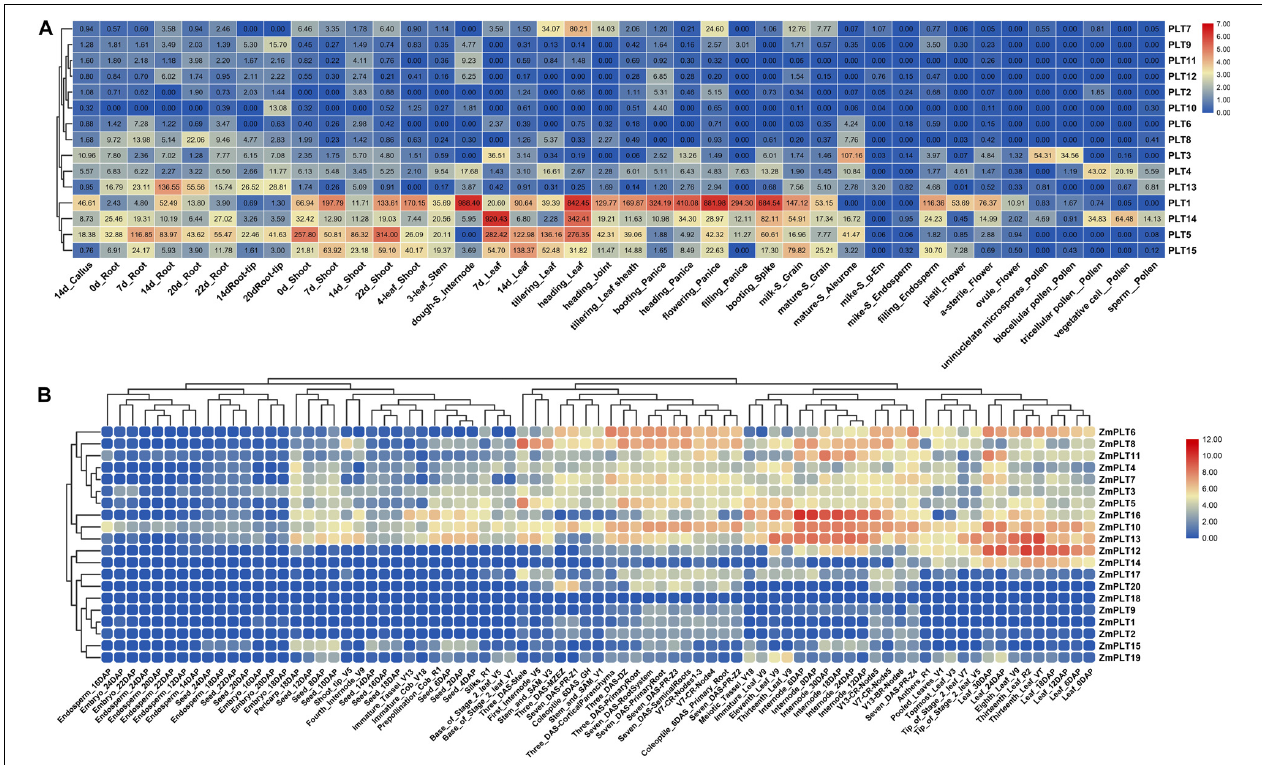
FIGURE 7 | Expression patterns of PLT genes in different tissues from rice (A) and maize (B) . The absolute expression values of rice PLT genes were obtained from MBKbase (http://www.mbkbase.org/rice). The absolute expression values of maize PLT genes were obtained from maize eFP Browser (http://bar.utoronto.ca/efp_maize/cgi-bin/efpWeb.cgi, data source: Hoopes et al.,